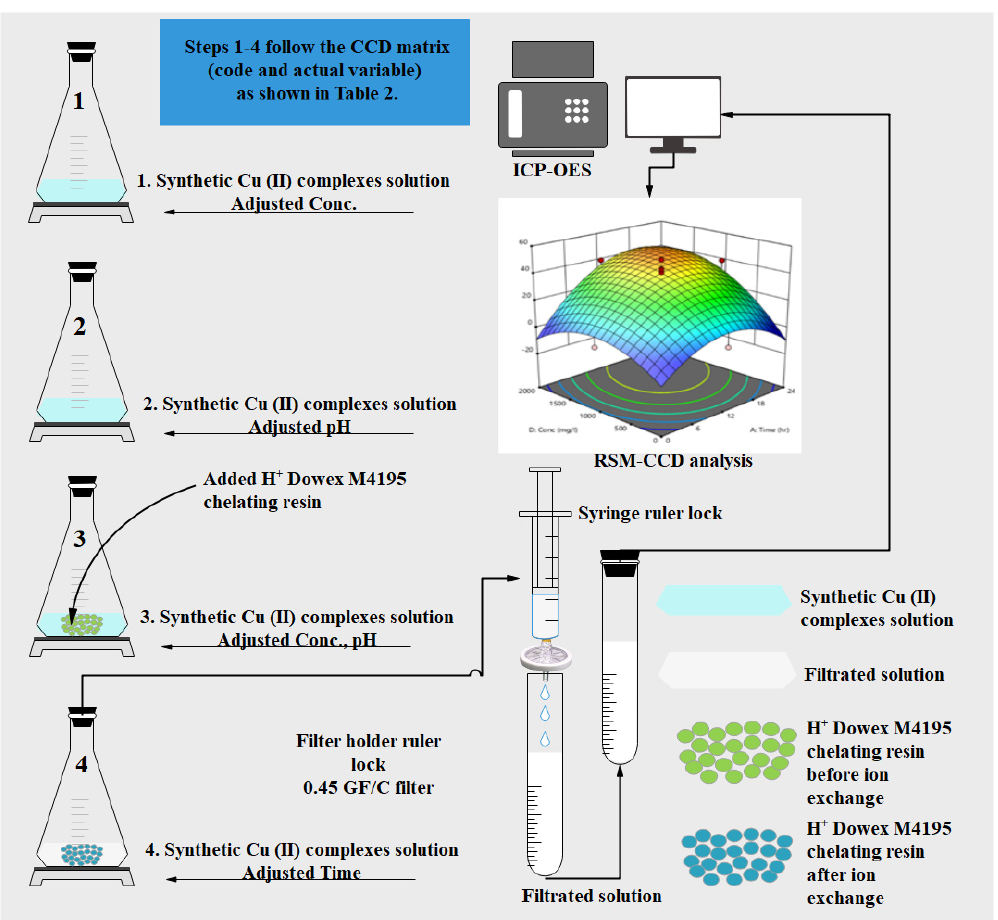
Figure 17. Optimization steps via batch ion exchange studies. Table 7. Thirty batch experiments of code and actual variable factors related to observed and predicted responses. Code Variable Run